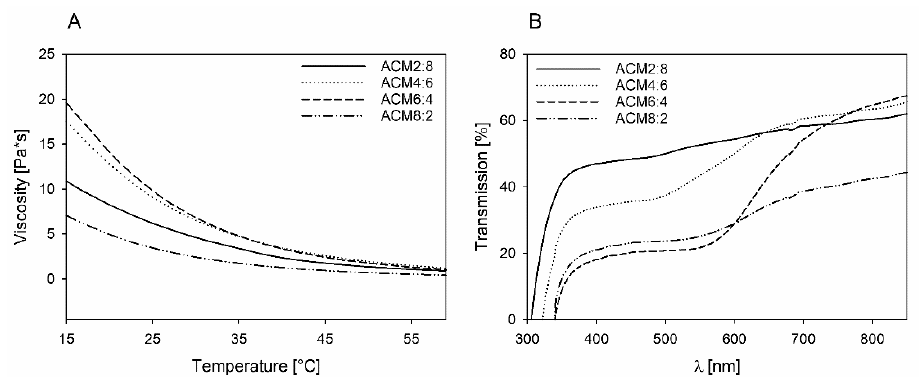
Figure 4. Physicochemical properties of ACM. ( A ) Temperature-dependent viscosity and ( B ) UV- Physicochemical properties of ACM. ( A ) Temperature-dependent viscosity and Vis Spectra. ( B ) UV-Vis